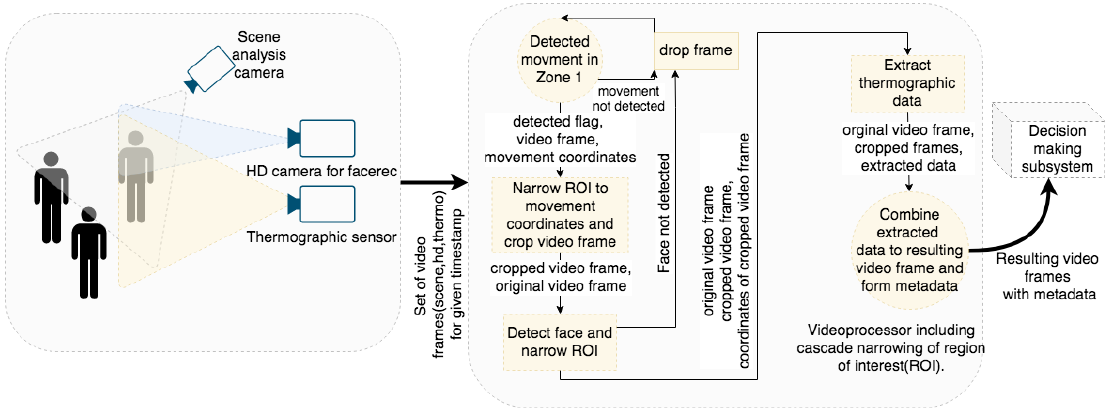
Figure 2. Simplified scheme of the processing of video input streams performed by the VISS.